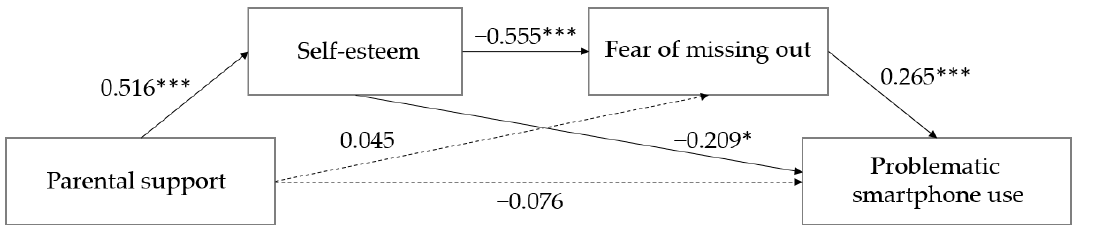
Figure 1. Serial mediation of self-esteem and fear of missing out in the relationship between parental support and problematic smartphone use with standard path coefficients. * p < 0.05; *** p < 0.001. Table 3. Results of path analysis .